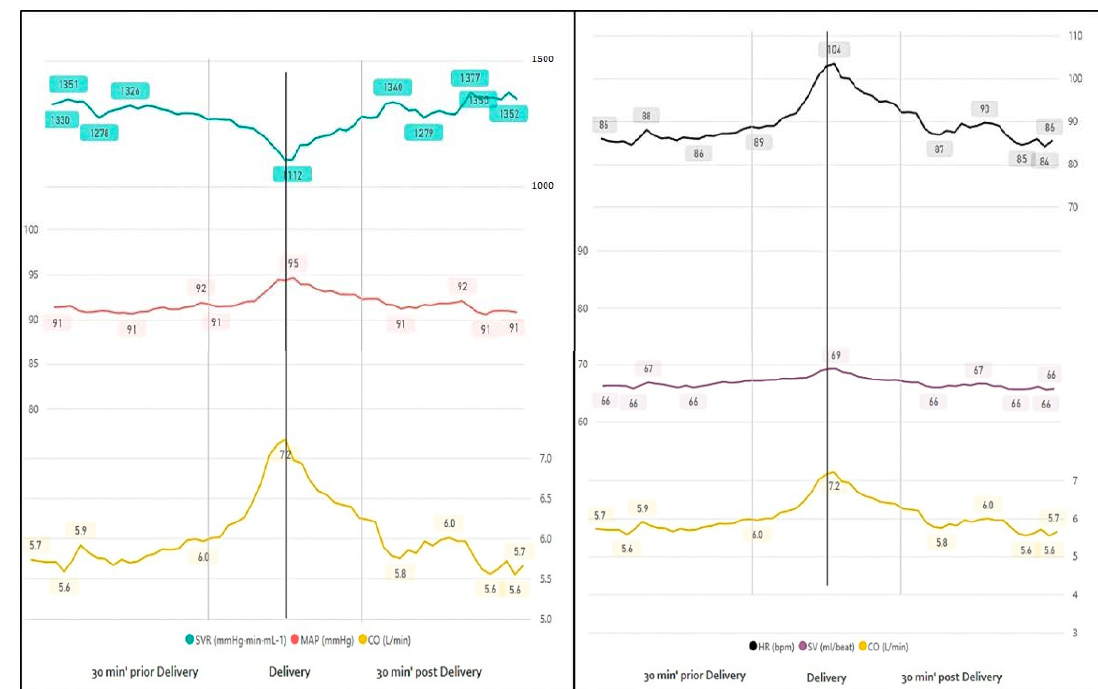
Figure 4. Continuous monitoring 30 min before and after delivery.